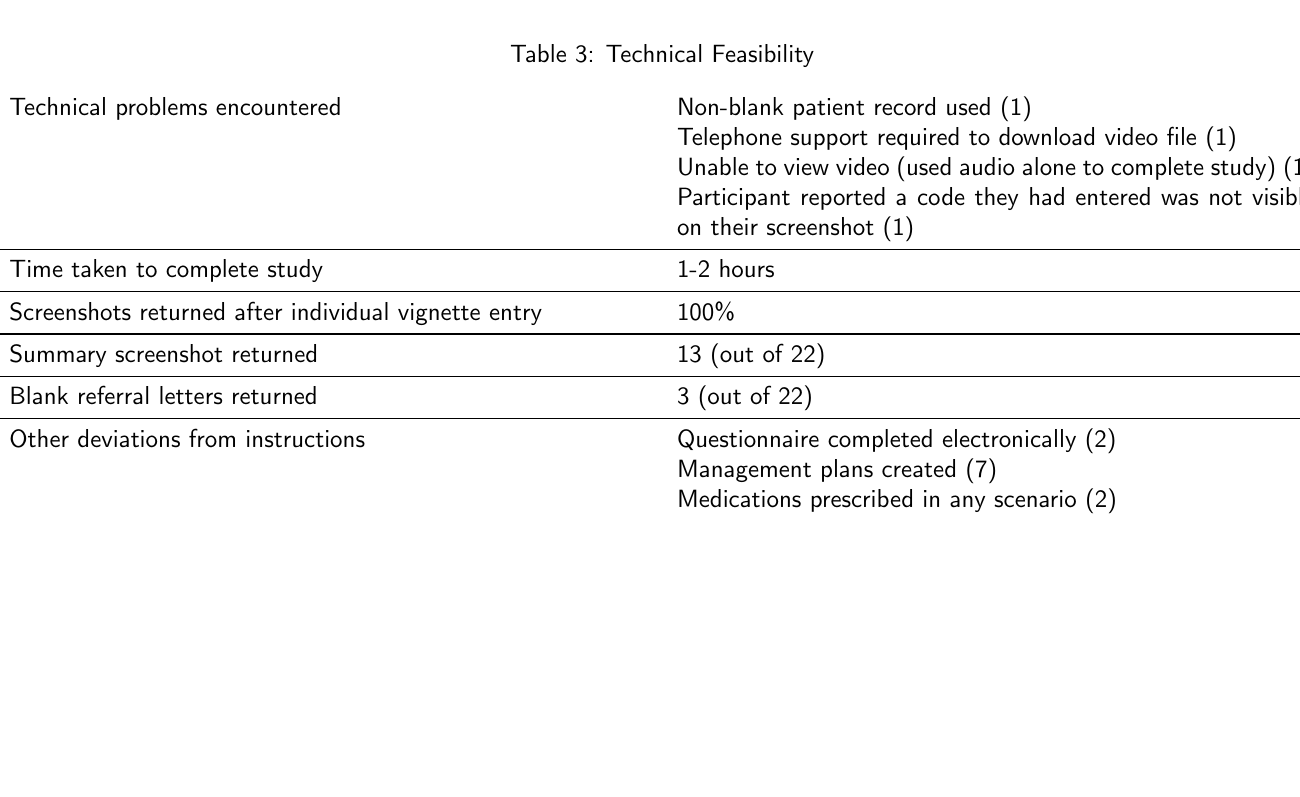
Table 4: Number of codes used for each vignette, participants rating of vignette information, reflection of real-life and quality and selected comments. Version 2 and 3 refer to Read code version which is dependent on EHR